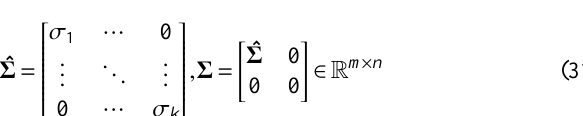
Figure 4. Key steps of dimensional reduction using singular value decomposition